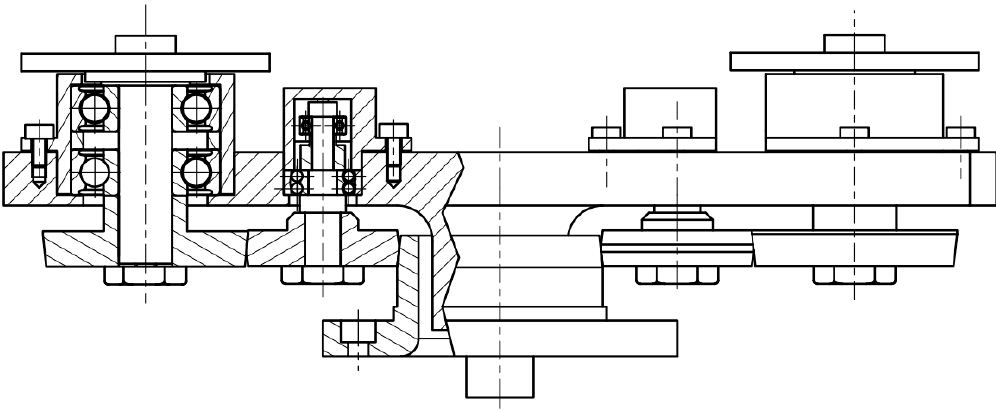
Figure 5. Partial section view of the moving parts and the central friction wheel.